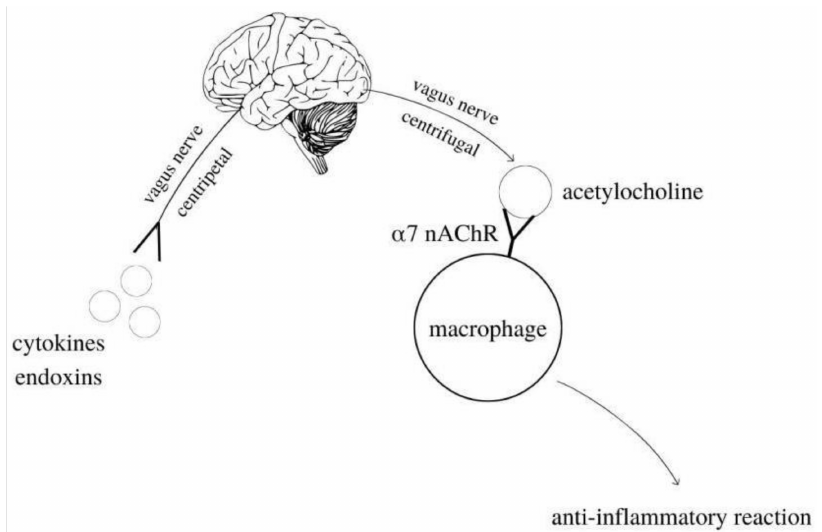
Figure 2. Inflammatory reflex. Cholinergic anti-inflammatory